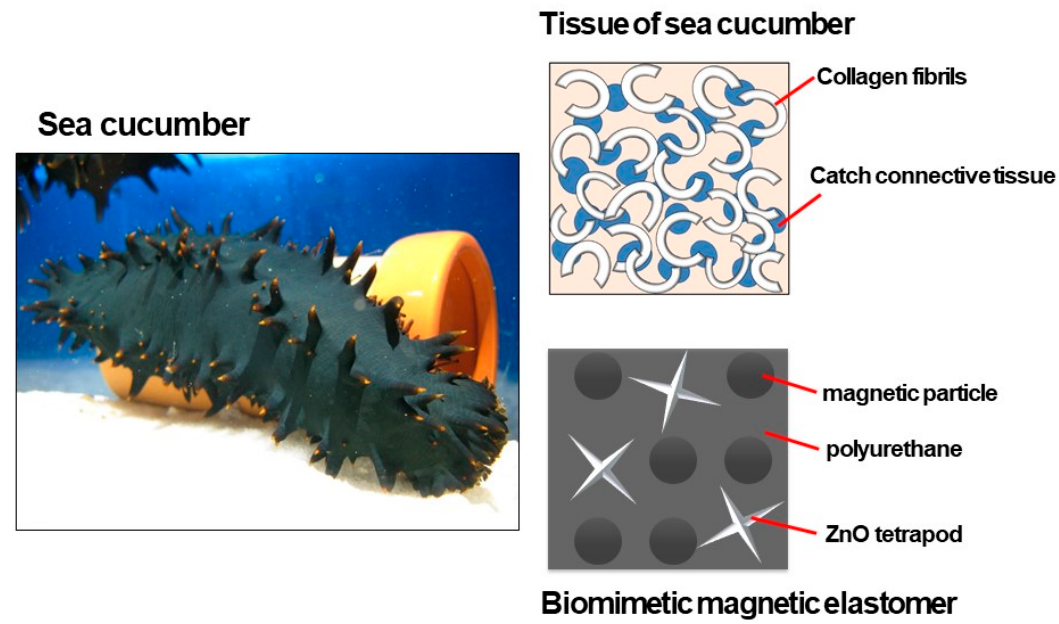
Figure 1. Photograph of a sea cucumber and schematic illustration representing the tissue of sea cucumbers, consisting of catch connective tissue and collagen.